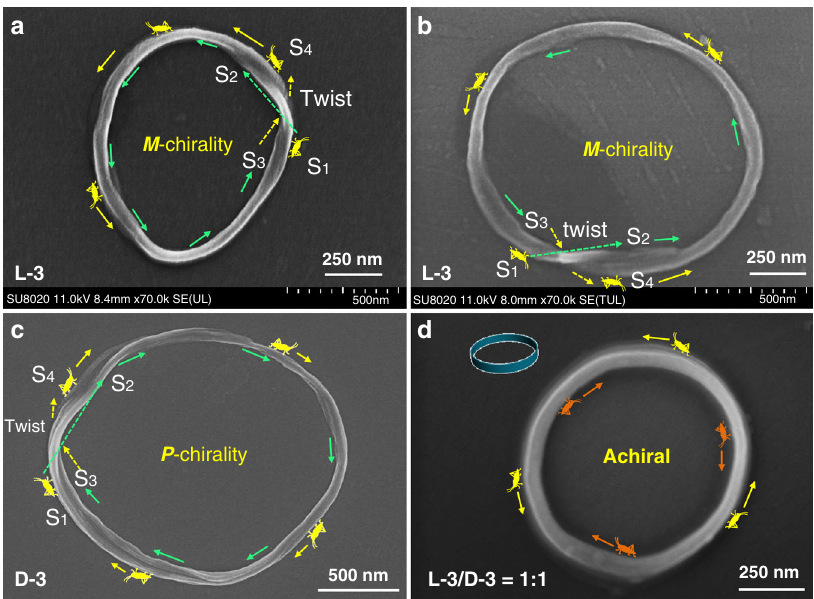
Fig. 3 Identi fi cation of chiral Möbius strips. a , b SEM images of L-3 assemblies showed Möbius strips with a single twist on the fi ber. c SEM image of D-3 assemblies showed a Möbius strip with a single twist on the fi ber. The yellow and green arrows are used to represent the walk direction of a reptile on the toroidal fi bers. d SEM image of L-3/D-3 (mole ratio 1:1) assemblies showing an achiral nanotoroid. The yellow and orange arrows are used to indicate the walk directions of two reptiles on the outer and inner faces, respectively. The concentration of amphiphile is 0.11 mM, pH = 2. Notes: M means left helicity and P means right helicity.